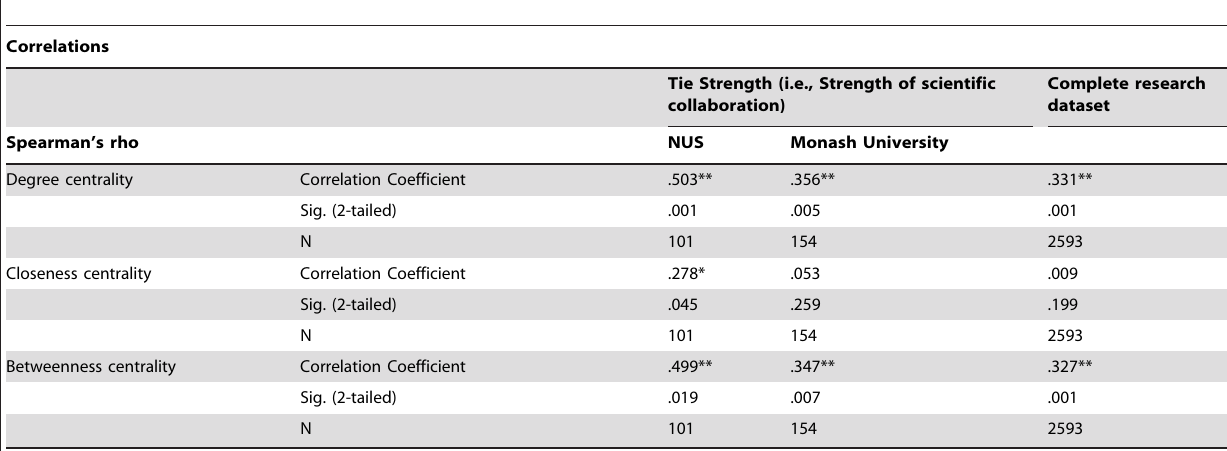
Table 5. Correlation matrix between three network centrality measures and strength of scientific collaboration (i.e., tie strength ) between two authors.